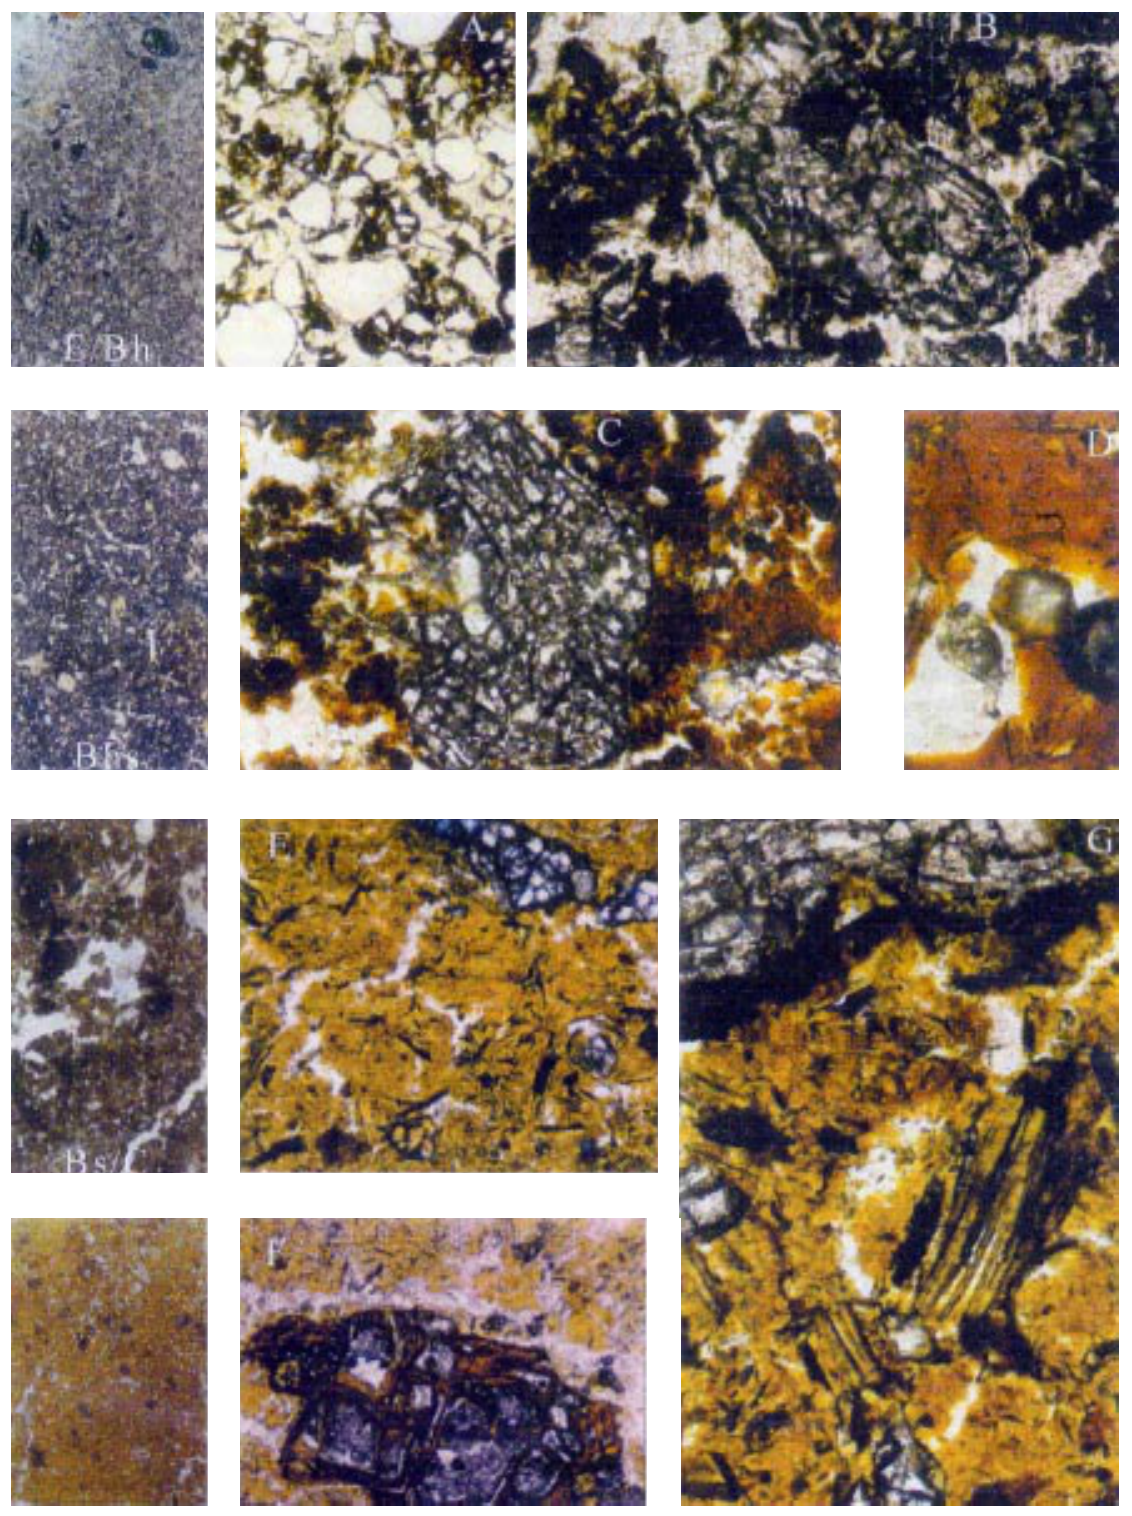
Figura 2. Fotomicrografias das lâminas em seção fina de uma seqüência do contato E/Bh, do horizonte Bhs, do horizonte Bs/C, e do saprolito de um Espodossolo Ferrocárbico; detalhes em objetivas de maior aumento (200X) de: (a) detalhe do horizonte E sob luz plana; (b) detalhe do horizonte Bh sob luz plana; (c) preenchimento do espaço intergranular com géis organominerais; (d) região de acúmulo de Fe; (e) matriz densa e siltosa do horizonte Bs/C; (f) pseudomorfo de feldspato substituído por gibbsita; e (g) pseudomorfos de biotita substituída por